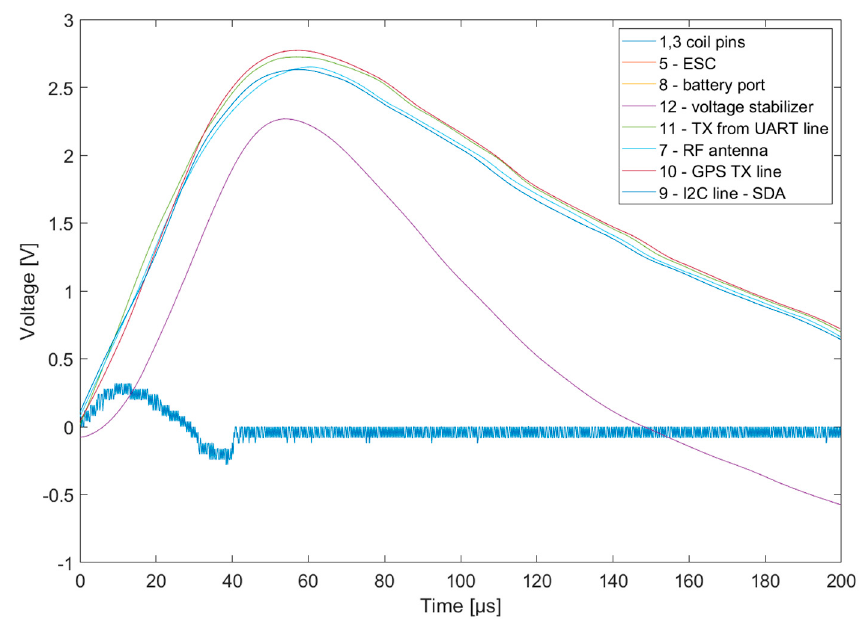
Figure 8. Overvoltage on all measurement circuits—input surge on supply bus (point no. 8) at positive polarity.